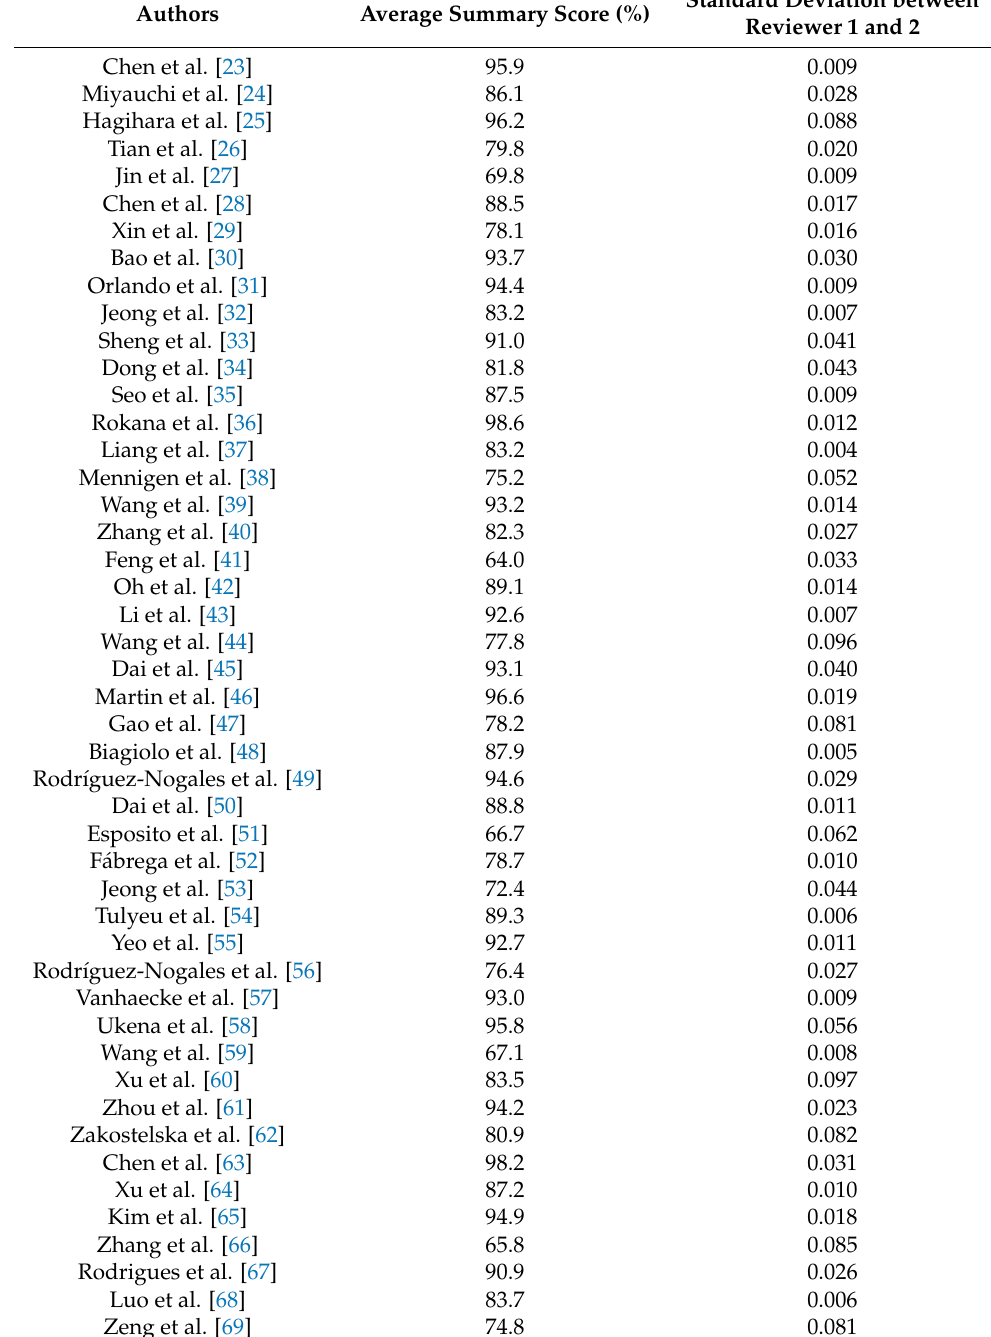
Table 2. The assessed results by the QualSyst of the collected